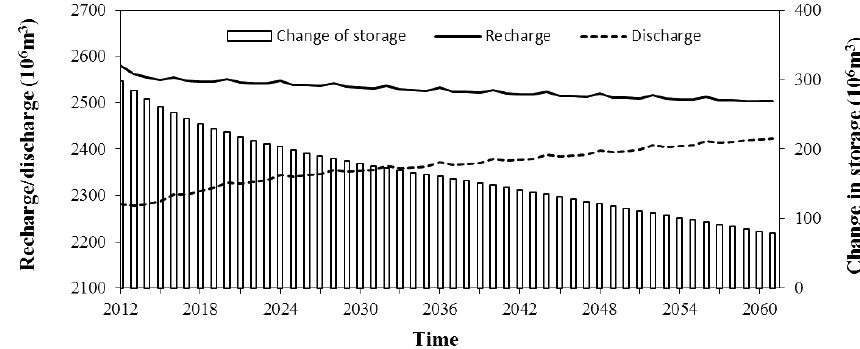
Figure 4. Change of groundwater balance under scenario